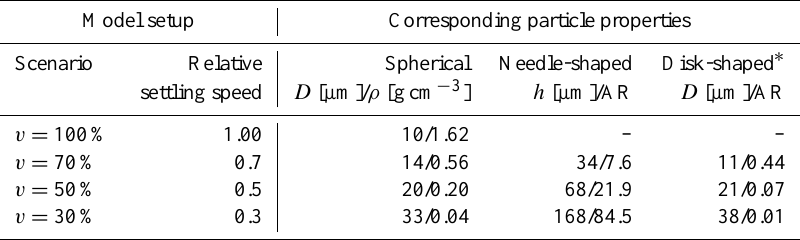
Table 1. CLaMS scenarios considering reduced settling velocities for simulated NAT particles ( v : velocity; D : diameter; ρ : particle mass density; h : height; AR: aspect ratio). All indicated example particles have the same mass but different relative settling velocities.